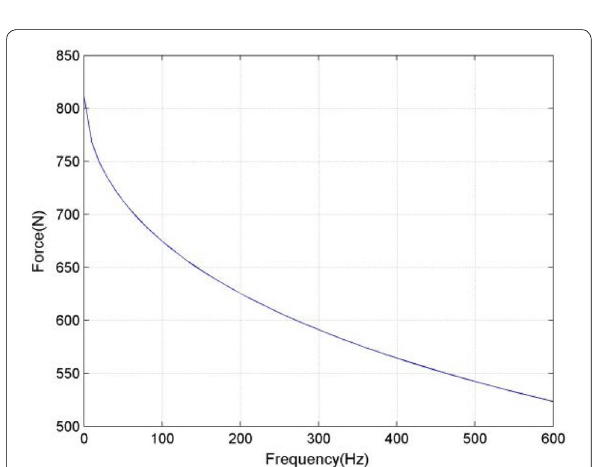
Figure 5 Dynamic axial force value at different